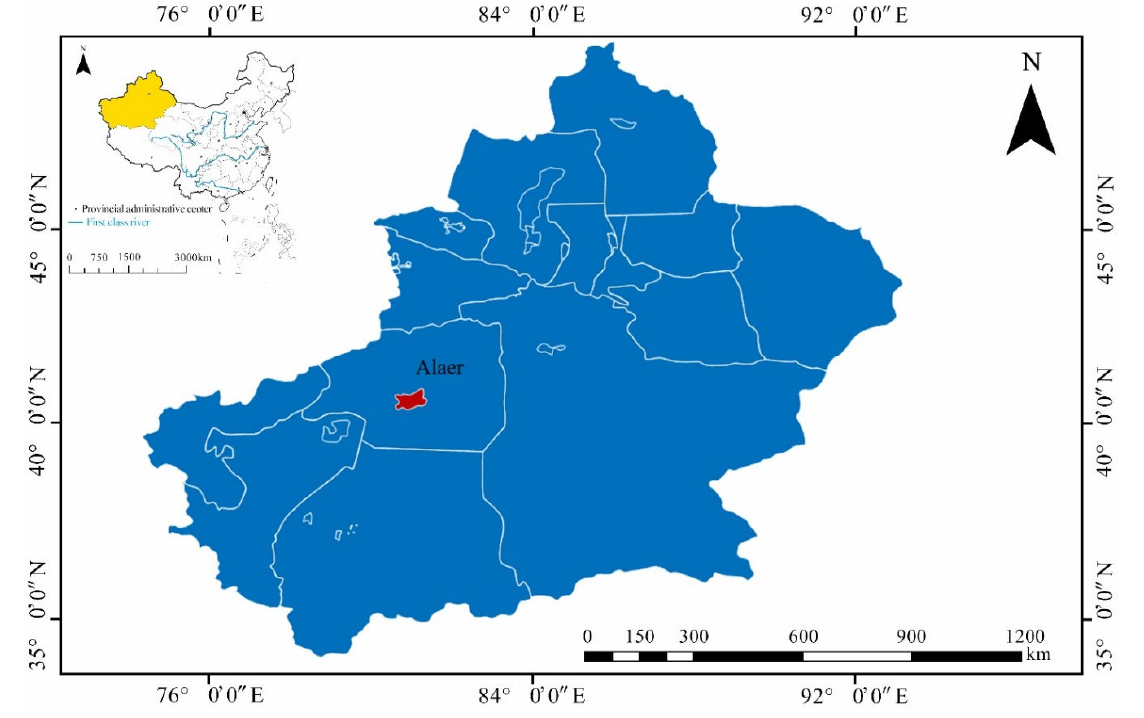
Figure 1. The location of the experimental site.